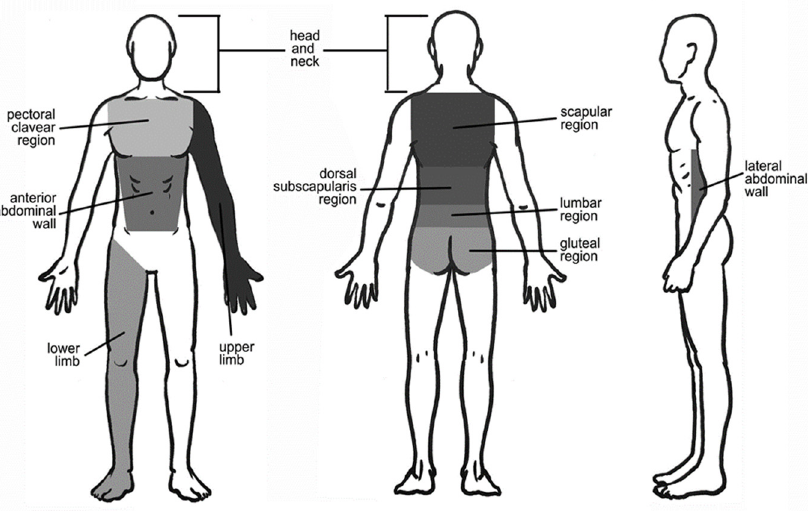
Figure 2 . Anatomical boundaries of the topographic location regions of the Figure 2. Anatomical boundaries of the topographic location regions of the melanomas melanomas studied.